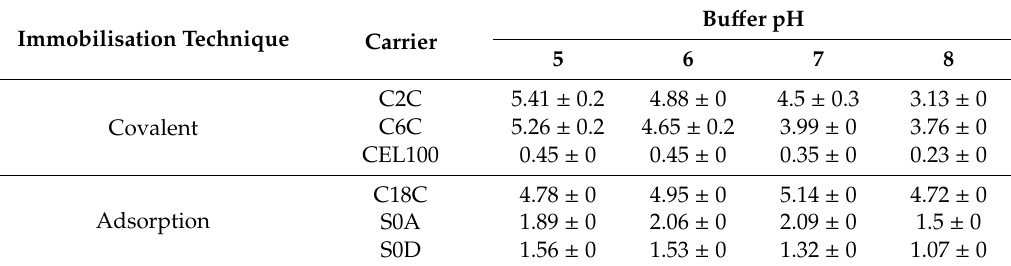
Table 2. Influence of phosphate bu ff er pH value on the activity of LAC [U / g] from P. ostreatus attached covalently or through adsorption on di ff erent porous